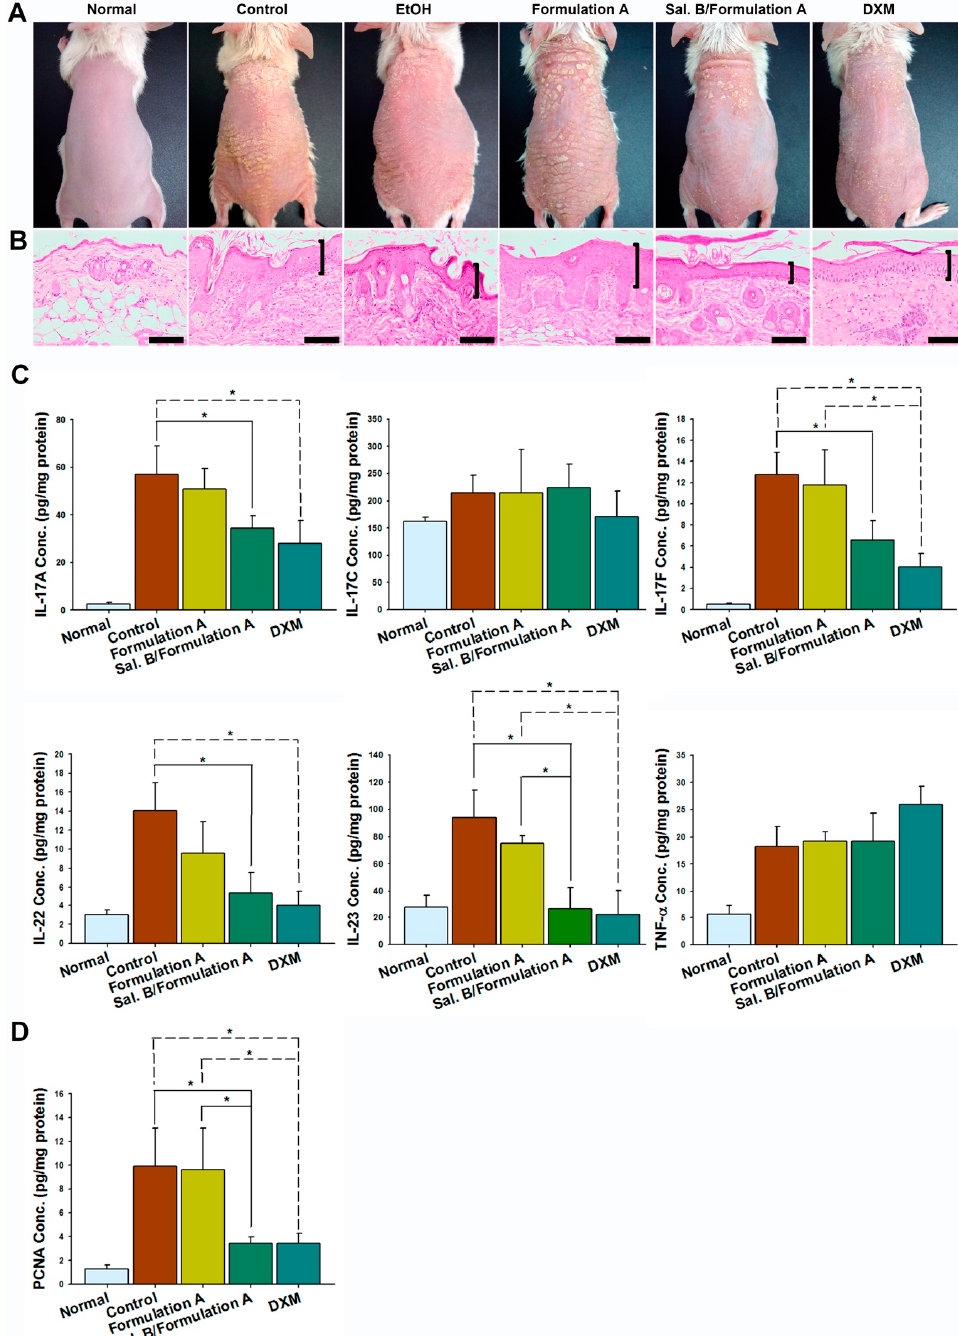
Figure 5. Sal. B / formulation A and DXM improve psoriasis-like dermatitis. ( A ) The morphology of all groups showed scales, erythema, and dry skin. ( B ) Histopathology by hematoxylin and eosin (H&E) staining showed epidermal acanthosis, parakeratosis, tortuous capillary dilatation in papillary dermis, and inflammatory cell infiltration in all groups. The Sal. B / formulation A and DXM treatment groups showed fewer severe clinical and pathological features than any of the other groups. Scale bar = 100 µ m. ( C ) Sal. B / formulation A and DXM inhibited interleukin-17A (IL-17A), interleukin-17F (IL-17F), interleukin-22 (IL-22), and interleukin-23 (IL-23) protein expression but not interleukin-17C (IL-17C) and tumor necrosis factor alpha (TNF- α ). ( D ) Sal. B / formulation A and DXM inhibited proliferation cell nuclear antigen (PCNA) protein expression (mean ± SD, n = 4); * p < 0.05; one-way ANOVA (Sche ff